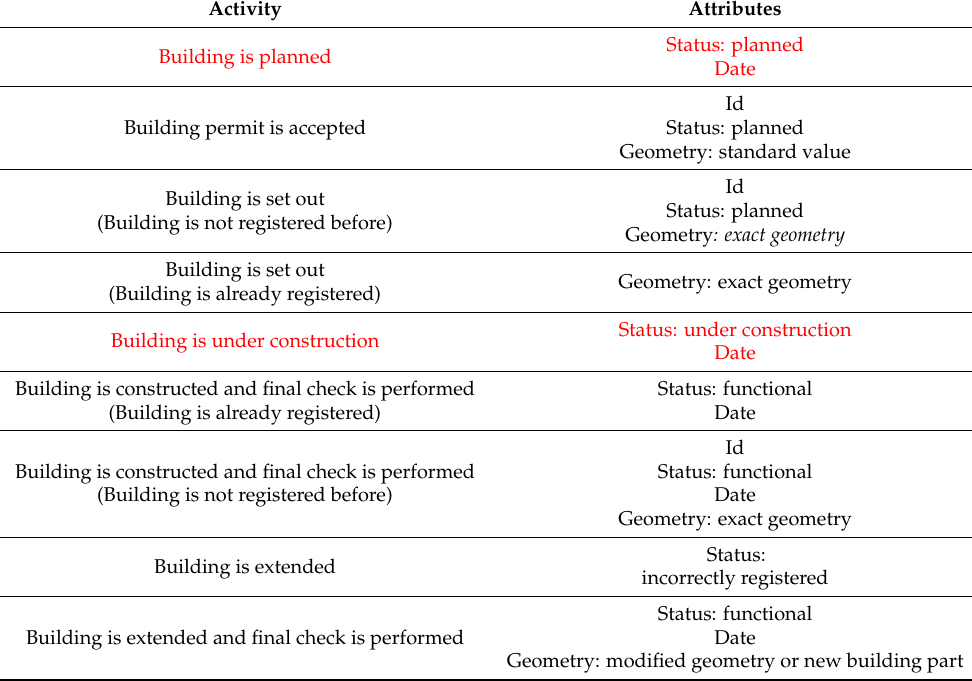
Table 1. Activities that municipalities perform to provide lifecycle and versioning information to the national mapping authority (NMA) during the lifetime of a building. Additional activities and versioning information that must be provided to the new national platform are indicated in red